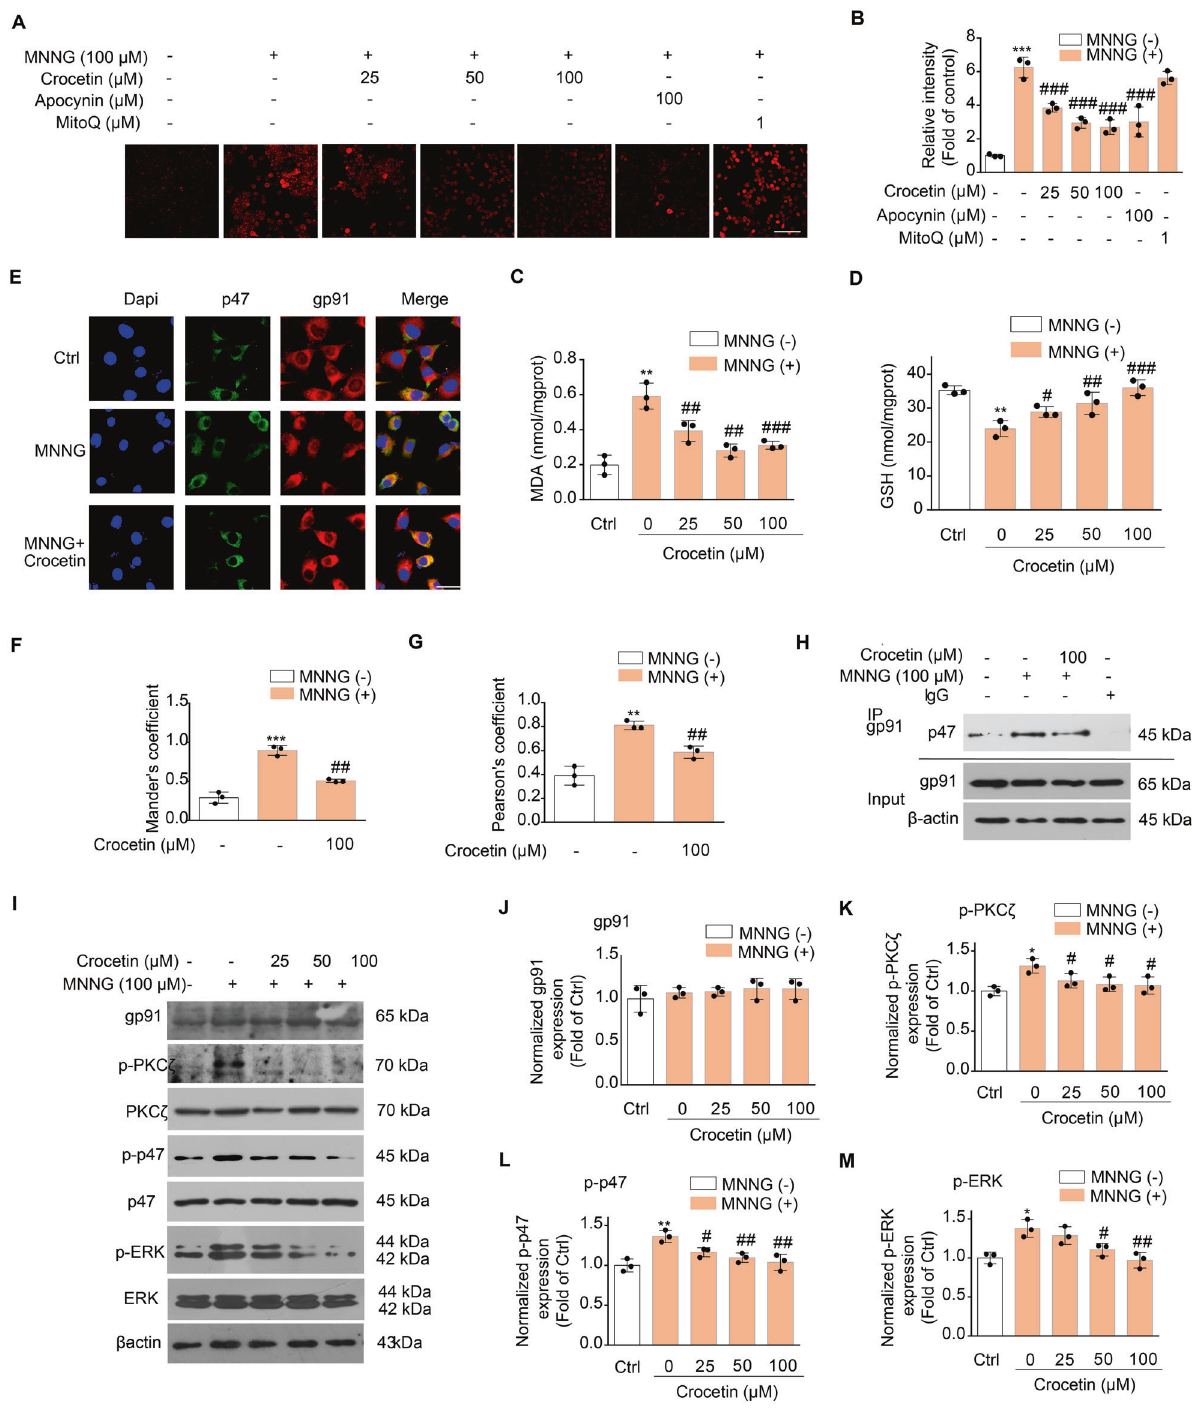
Fig. 5 Crocetin reduced ROS production by inhibiting NOX2 activity. A Effect of crocetin on MNNG-induced ROS generation (red) in SH- SY5Y cells. Cells were pretreated with crocetin (25, 50, 100 μ M) for 1 h and then exposed to MNNG (100 μ M) for 15 min. Scale bar: 40 μ m. B Group quanti fi cation of ROS fl uorescence intensity in ( A ) from three independent experiments. C , D Effect of crocetin on MDA level ( C ) and GSH level ( D ) in MNNG-induced early stage of parthanatos. E Confocal images of NADPH oxidase subunits p47phox (green) and gp91phox (red) and DAPI (blue). Cells were pretreated with crocetin (100 μ M) for 1 h before MNNG (100 μ M) stimulation for 15 min. Scale bar: 10 μ m. F Mander ’ s coef fi cient between gp91 and p47 staining. G Pearson ’ s correlation coef fi cient between gp91 and p47 staining. H Co- immunoprecipitation assay shows MNNG-induced binding between p47phox and gp91phox. Cells were pretreated with crocetin (100 μ M) for 1 h before MNNG (100 μ M) stimulation for 15 min, and cellular lysates were immunoprecipitated using anti-IgG or anti-gp91phox antibodies and immunoblotted using the indicated antibodies. I Effect of crocetin on MNNG-induced phosphorylation of PKC ζ , p47phox, and ERK. J – M Group quanti fi cation of gp91 ( J ), p-PKC ζ ( K ), p-p47 ( L ), p-ERK ( M ) in ( I ) from three independent experiments. Signi fi cance was determined by one-way ANOVA. * p < 0.05, ** p < 0.01, *** p < 0.001, vs control group; # p < 0.05, ## p < 0.01, ### p < 0.001, vs MNNG